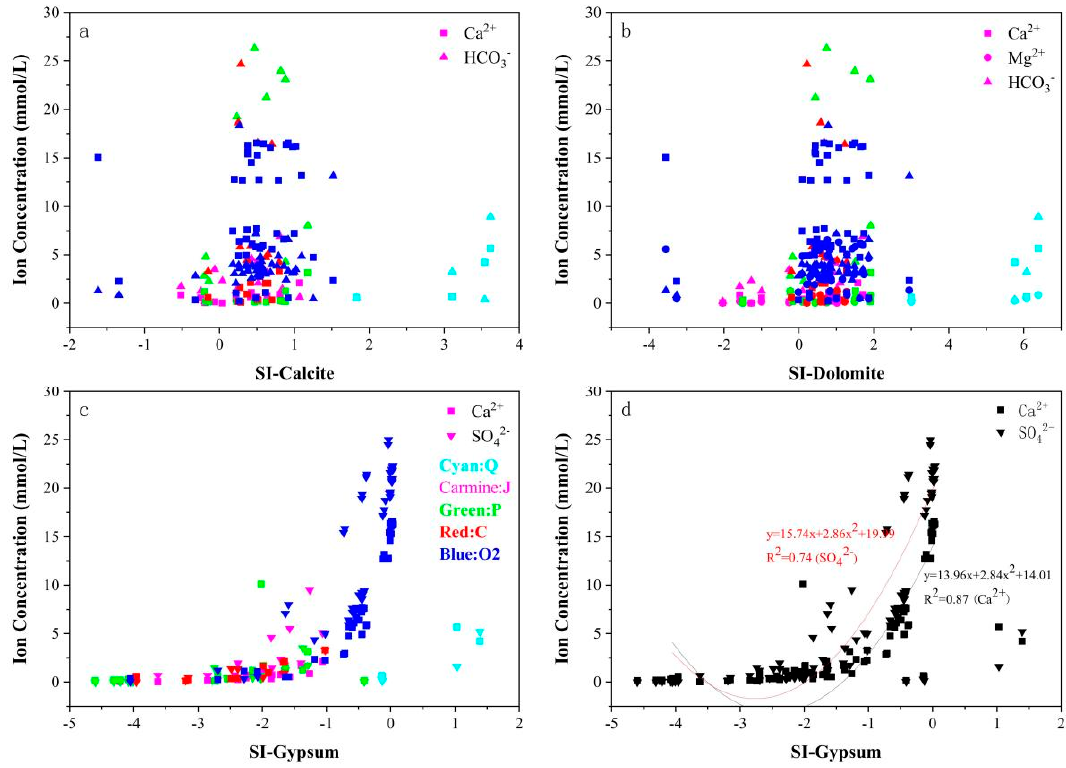
Figure 5. Relationship between different mineral saturation and ion concentration: ( a ) Calcite; ( b ) Dolomite; ( c ) and ( d ) Gypsum. ( b ) Dolomite; ( c , d )